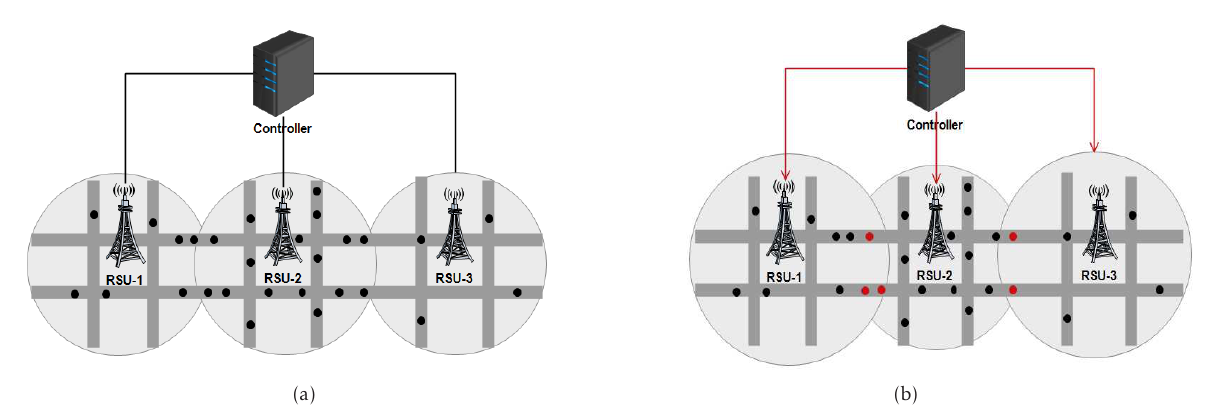
Figure 2. (a) Each vehicle is served by a RSU in the vehicular network topology (b) The controller manages to RSUs by coordinating vehicles with the proposed model.